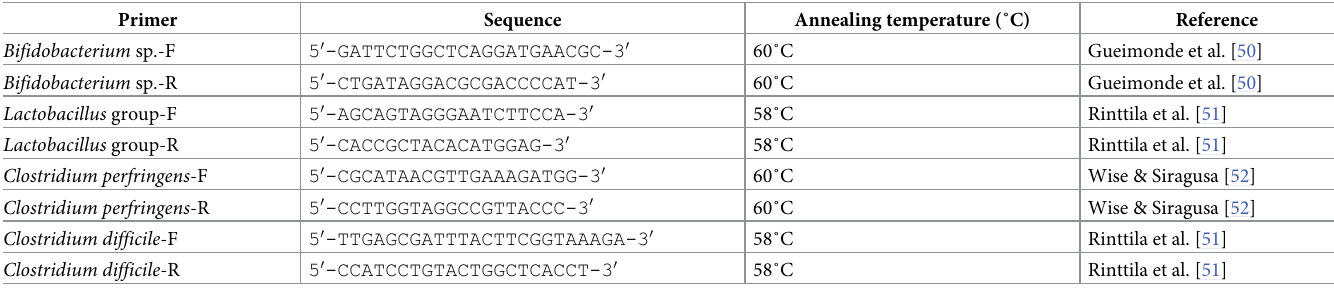
Table 1. For each reaction described above, the positive control and negative water control were assayed together with samples. The melting curves of the amplified DNA were generated to verify the specificity of the reaction. To construct standard curves, 10-fold diluted target Table 1. Primers and thermal cycling profiles used in this study.